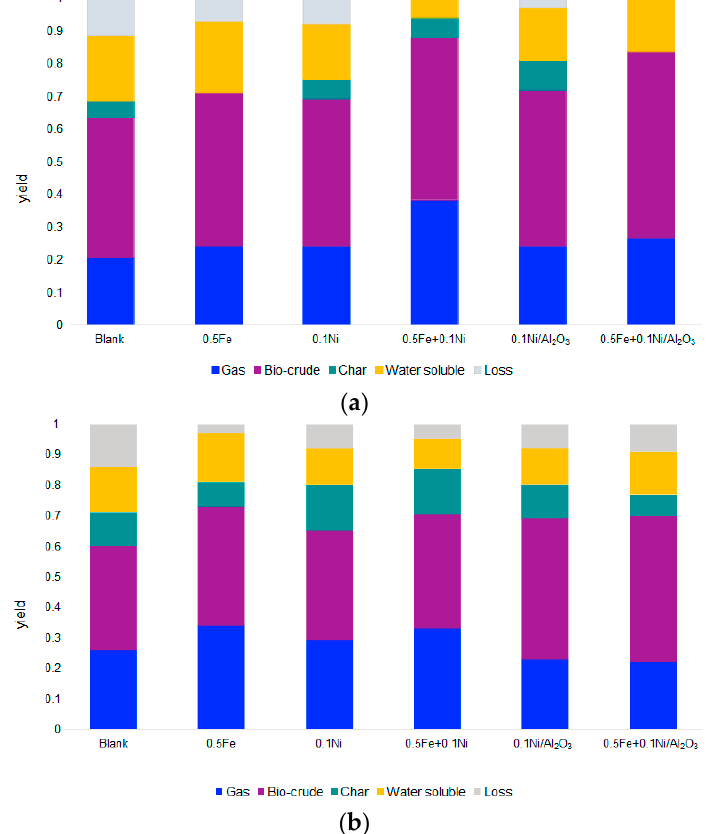
Figure 4. Effect of catalyst in HTL of ( a ) BS and ( b ) BM at 330 °C for a residence time of 10 min.